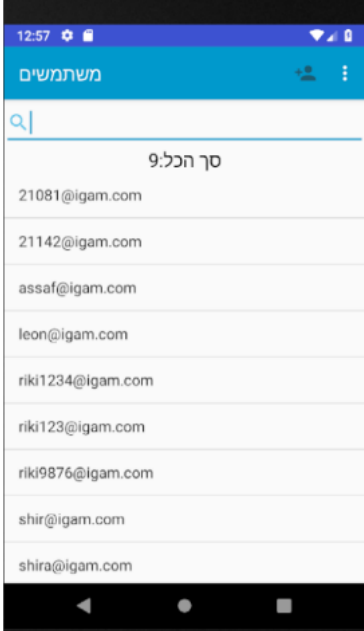
Figure 20. Patient list screen for the dentist: the dentist can view the list of